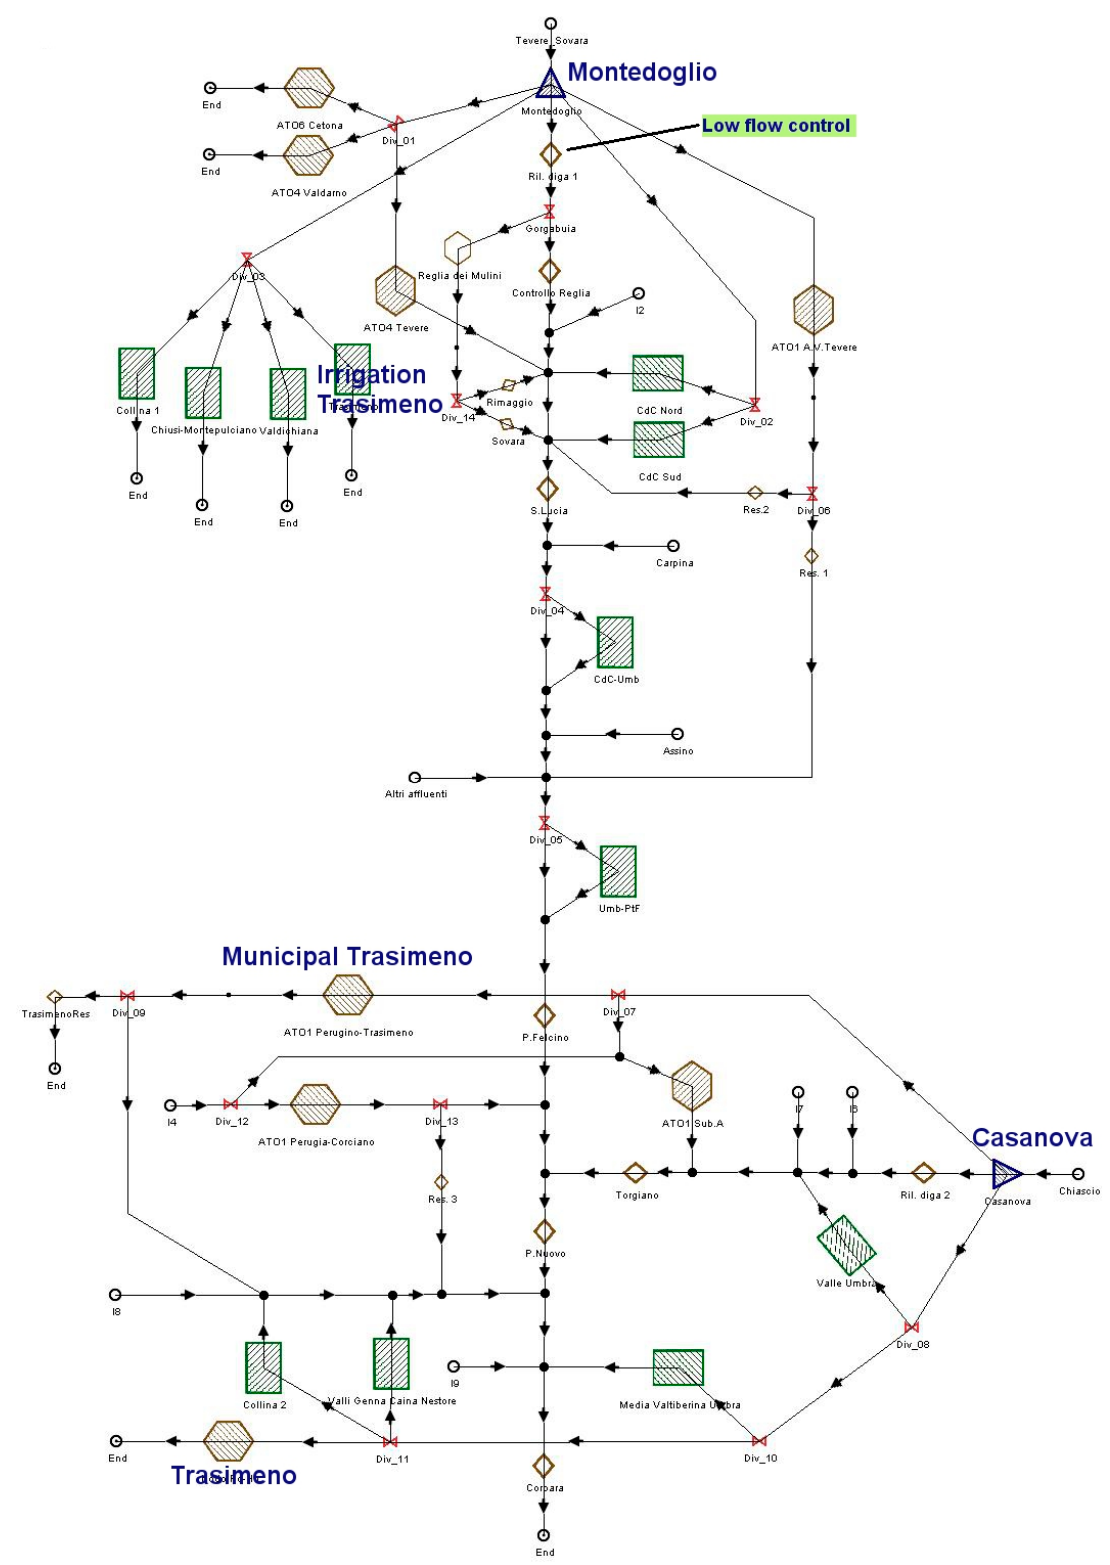
Figure 3. Sketch of the hydraulic system—Montedoglio—Casanova—Trasimeno. The scheme highlights all the water demands (irrigation rectangle symbol, municipal hexagon symbol, and the control node for the minimum instream flow, rhombus symbol). In the case of